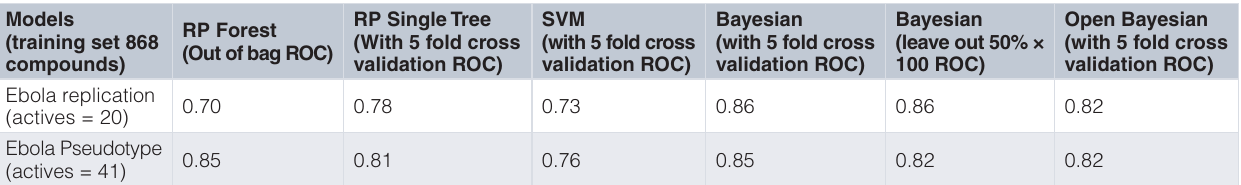
Table 1. Machine learning model cross validation Receiver Operator Curve (ROC) statistics. Models (training set